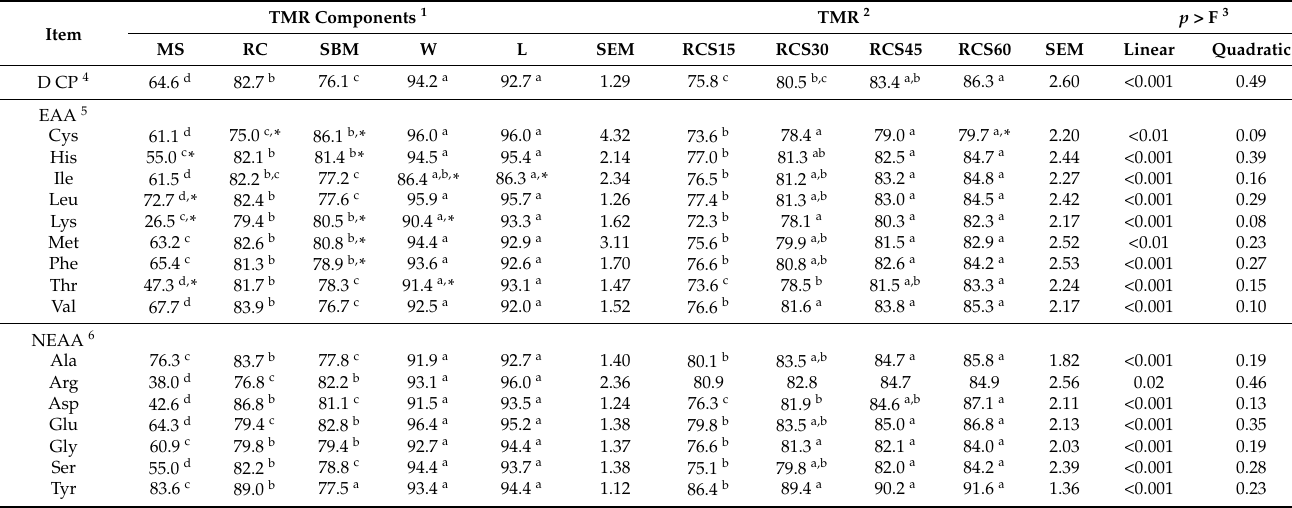
Table 4. Ruminal degradation (D) in % of crude protein (CP) and amino acids (AAs) of individual feeds and total mixed rations (TMR) after 16 h of